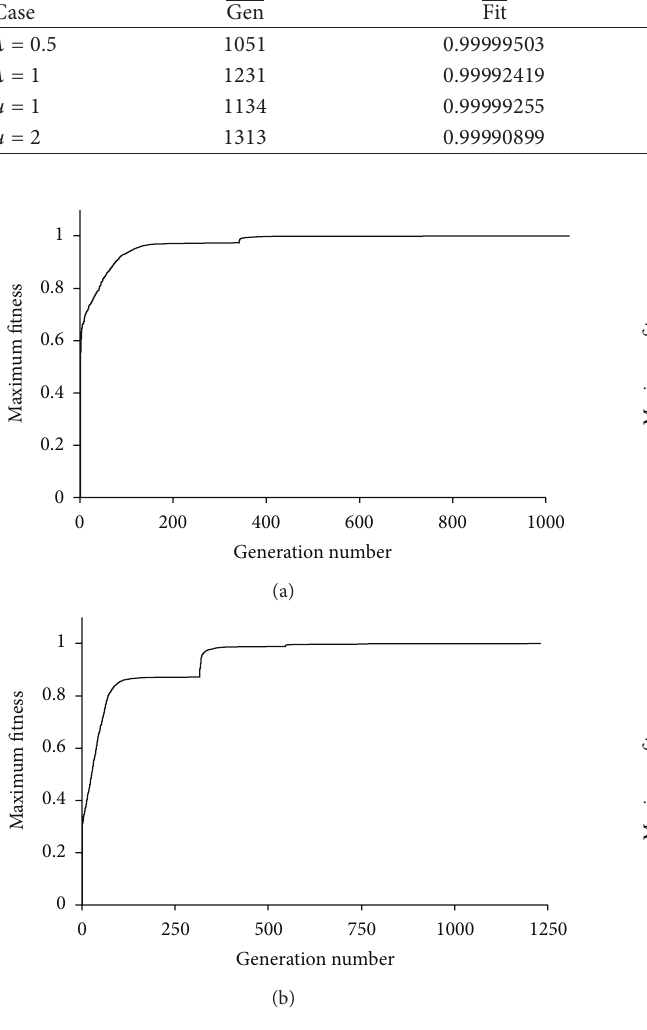
Figure 2: Plot of the best-fitness function for Troesch’s problem when (a) 𝜆 = 0.5 and (b) 𝜆 = 1 .